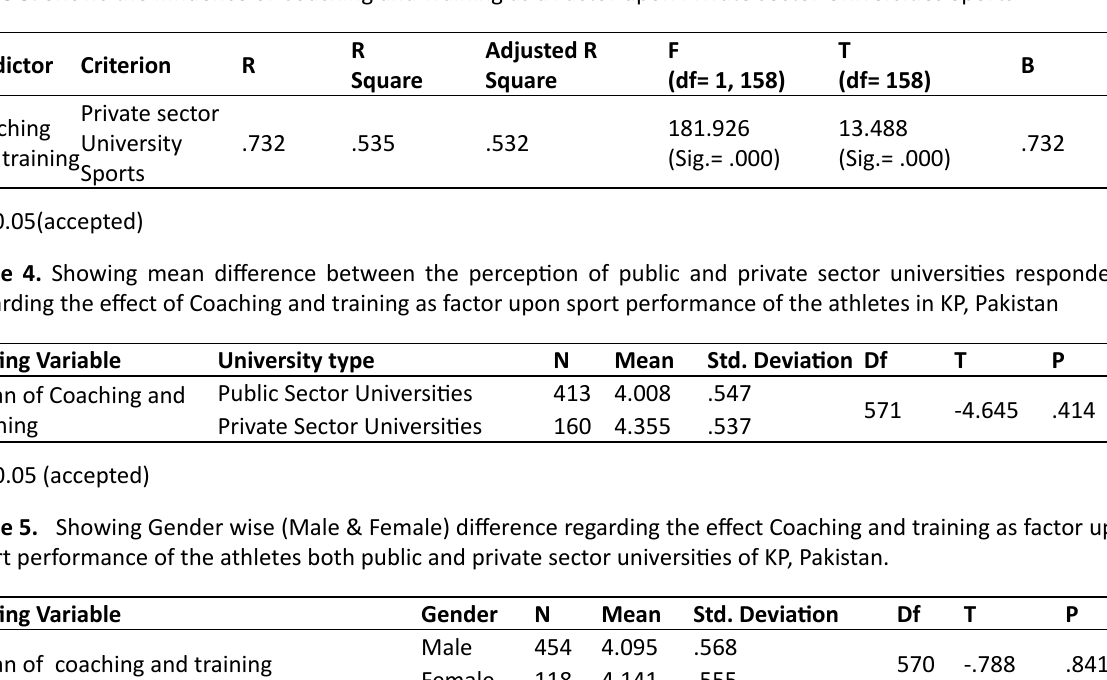
Mean of coaching and training